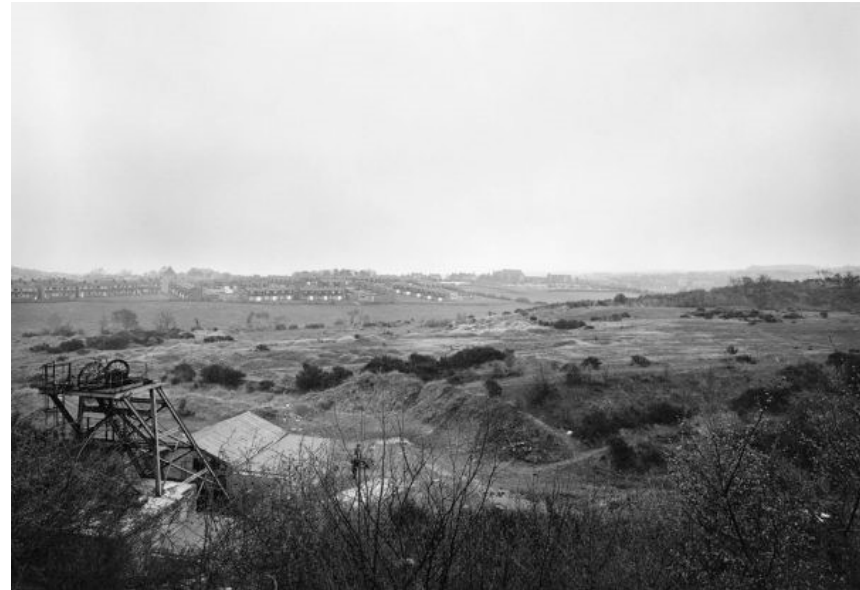
Figure 1. John Davies, Private Coal Mine Sacriston, Co. Durham , 1983. © John Davies 1983. Reproduced with kind permission of John Davies and Amber/Side. 1